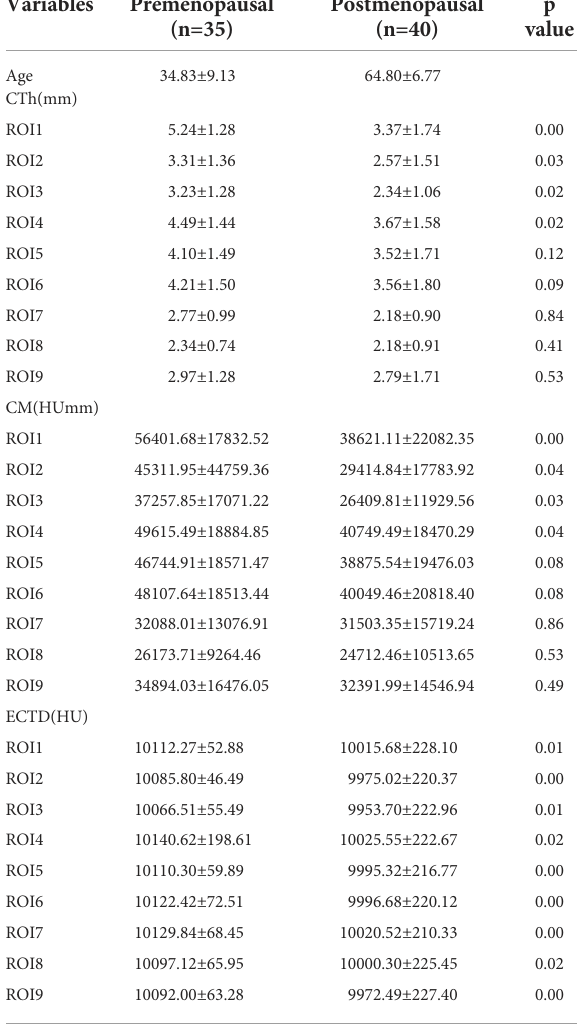
TABLE 1 Menopause-related difference in variables of ROIs of the